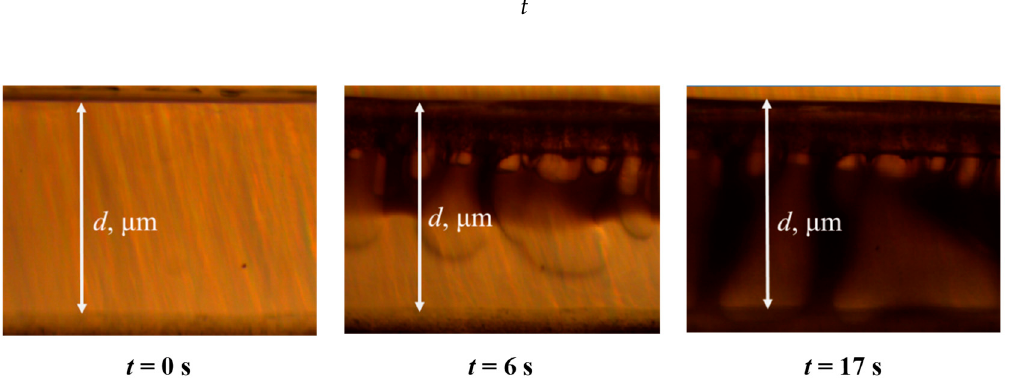
Figure 3. Photomicrographs captured in the study of the deposition kinetics by a new method.